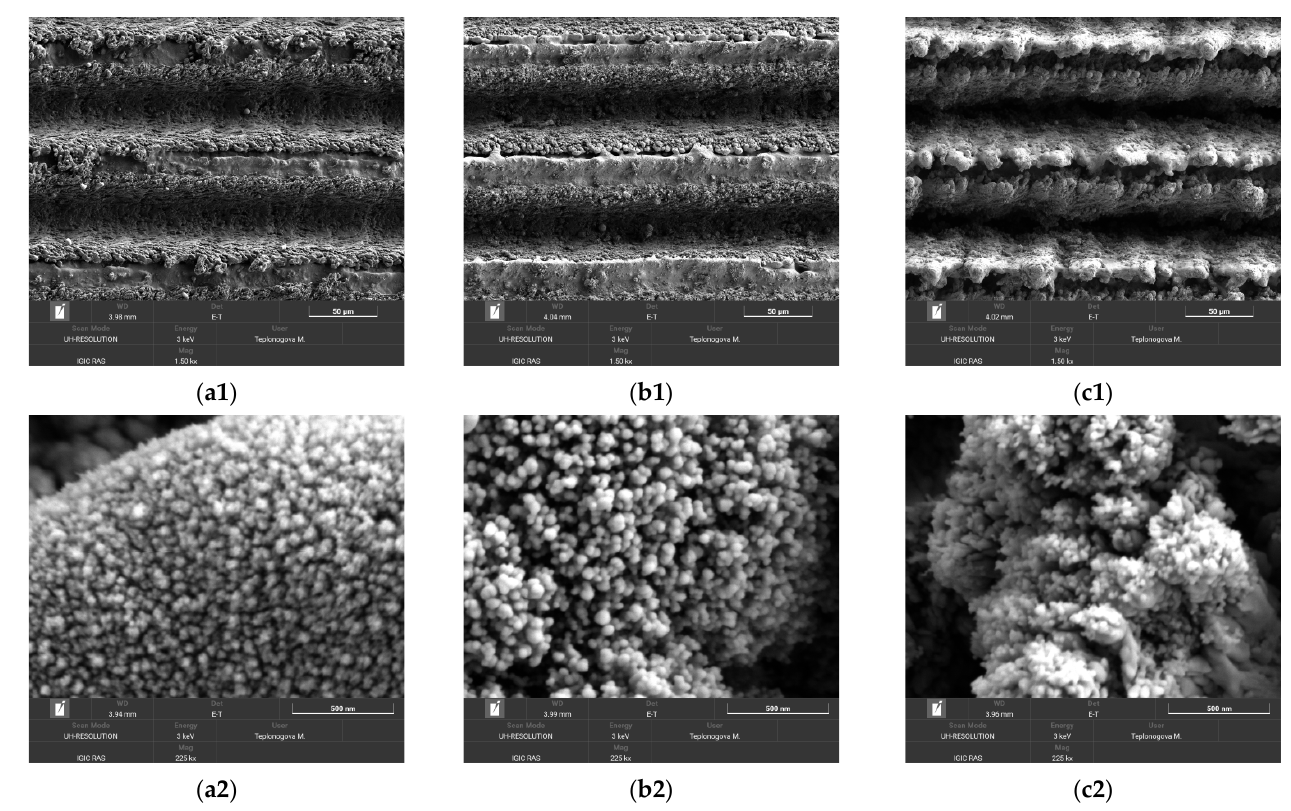
Figure 2 . SEM images of tungsten samples after the laser treatment by regimes 3 (images a1 , a2 ), 10 ( b1 , b2 ), and 13 ( c1 , c2 ) at different magnifications. Scale bars: 50 μm ( a1 to c1 ) and 500 nm ( a2 to c2 ).